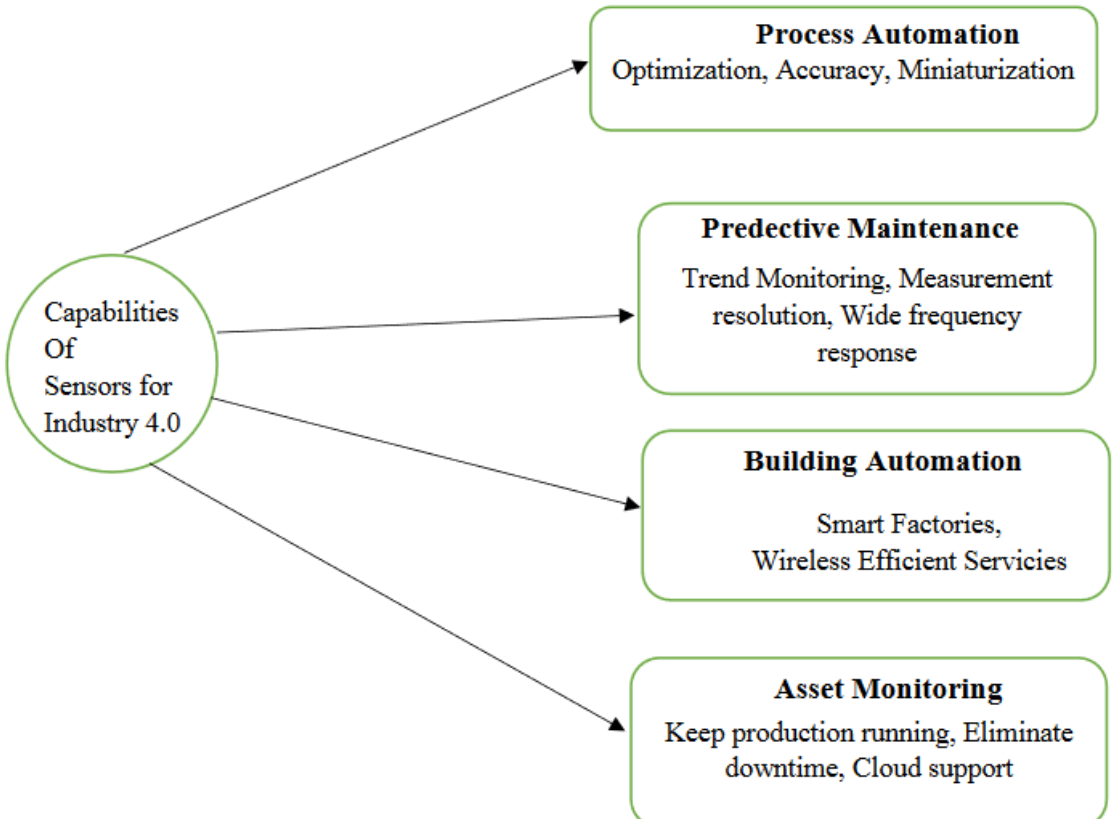
Figure 17. Instrumentation for Industry (Manufacturing) 4.0.